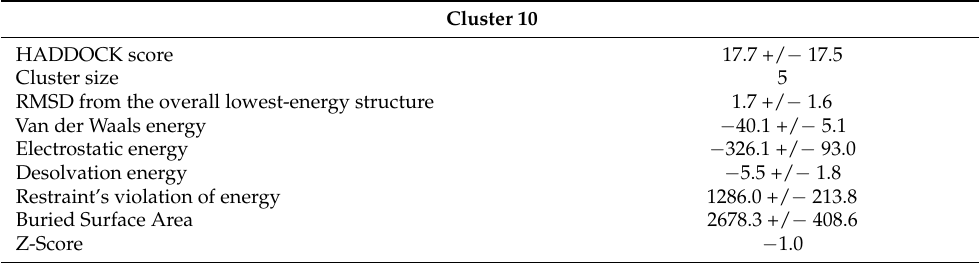
Table 6. Protein–protein docking results between TLR-4 and vaccine